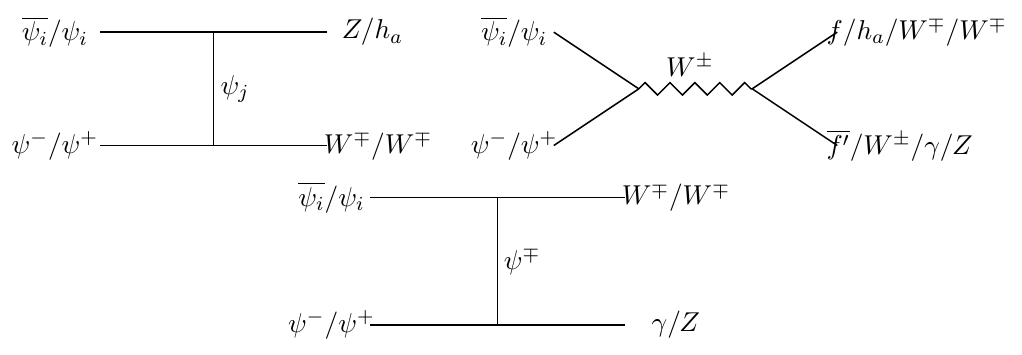
Figure 16 . Feynmann diagrams for co-annihilation type number changing processes of i ( i = 1 ; 2) with the charged component